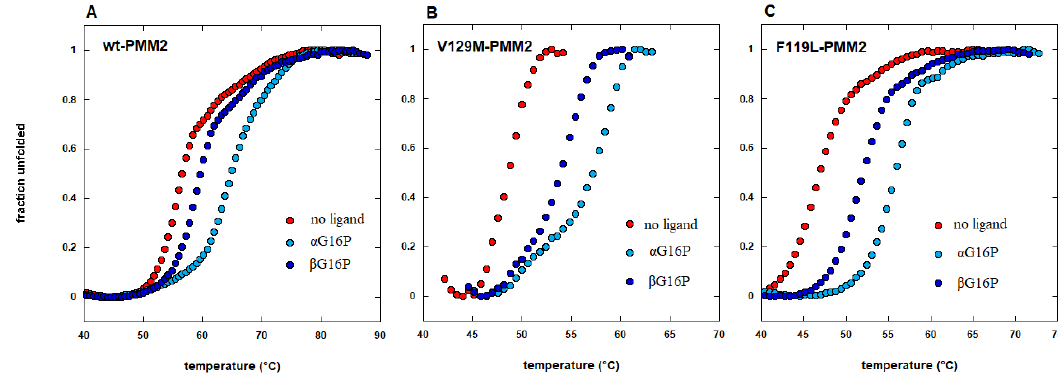
Figure 5. The e ff ect of pharmacological chaperones is observed on responsive mutants as well as on wild type proteins. Thermal shift analysis of wild type phosphomannomutase2 (wt-PMM2 in panel A) and two pathological mutants (V129M-PMM2 in panel B and F119L-PMM2 in panel C) in the absence or in the presence of two di ff erent pharmacological chaperones, 1,6-alpha glucose-bisphosphate ( α G16P) or 1,6-beta glucose-bisphosphate ( β G16P) (extracted from reference